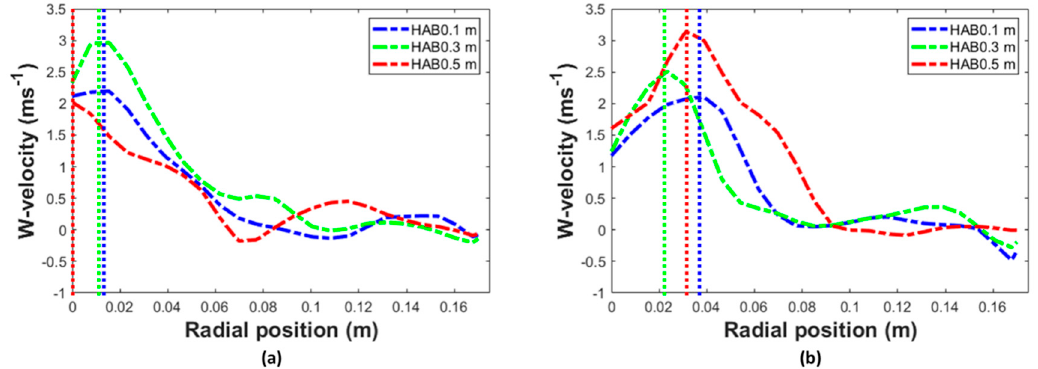
Figure 14. Plot of axial velocity, along with the radial direction at three monitoring HABs: 01 slit case ( a ), and 02 slit case ( b ).